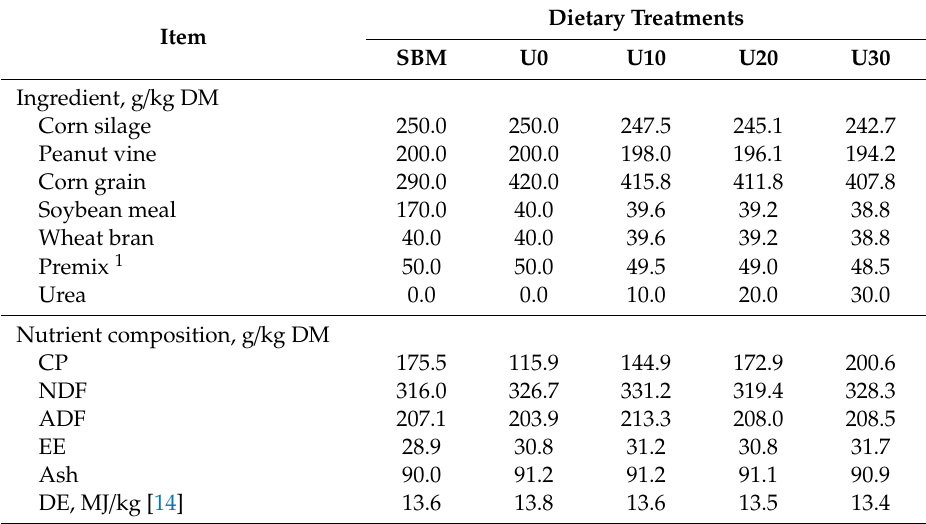
Table 1. Ingredient and chemical composition of the experimental